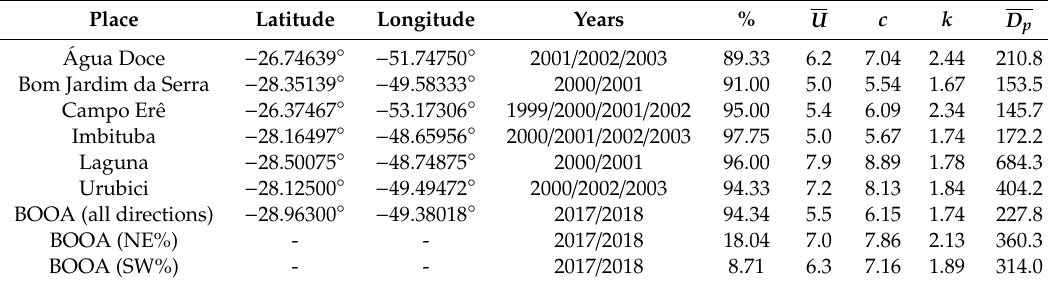
Table 5. A comparison of the BOOA winds with the wind resources estimated by the meteorological towers provided by Dalmaz (2007) [15]. The BOOA LIDAR measurements are relative to a height of 49 m, and most of the towers discussed by Dalmaz (2007) were 48 m high. Only the measurements of Campo Er ê had a height of 30 m. BOOA (NE%) examines winds between 30 ◦ and 60 ◦ . BOOA (SW%) examines winds between − 150 ◦ and − 120 ◦ . The symbol % represents the availability of data. Only years with > 80% availability are included. U is the horizontal wind speed (m s − 1 ), c is the Weibull scale parameter (m s − 1 ), k is the Weibull shape parameter, and D p is the mean power density (W m − 2